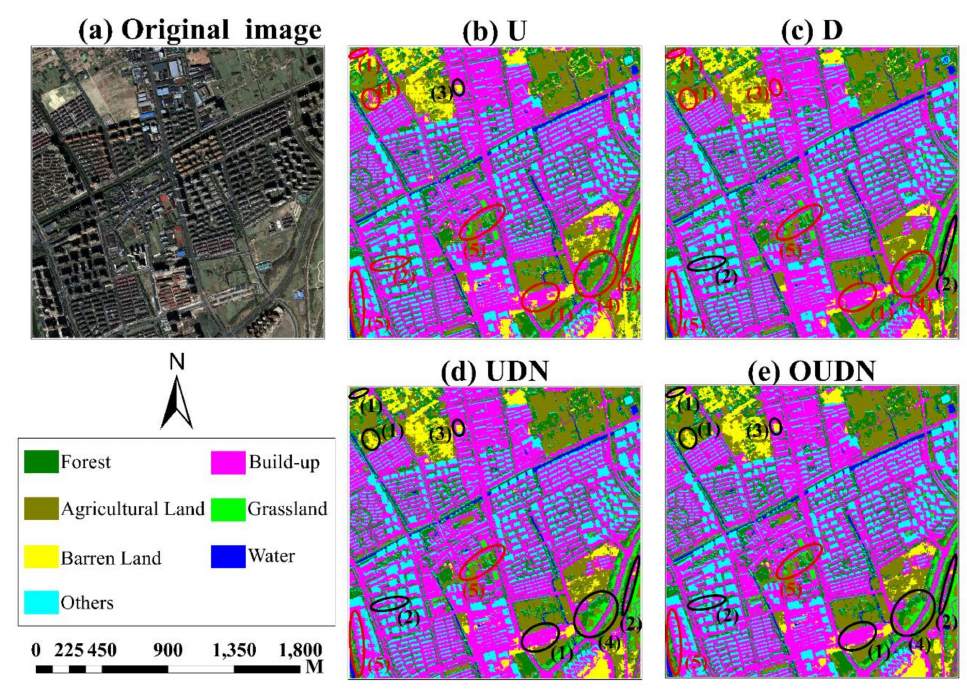
Figure 8. ( a ) Original image; ( b ) the classification map of the U algorithm based on the Spe; ( c ) the classification map of the D algorithm based on the Spe; ( d ) the classification map of the UDN algorithm based on the Spe; ( e ) the classification map of the OUDN algorithm based on the Spe; and the red and black circles denote incorrect and correct classifications, respectively.